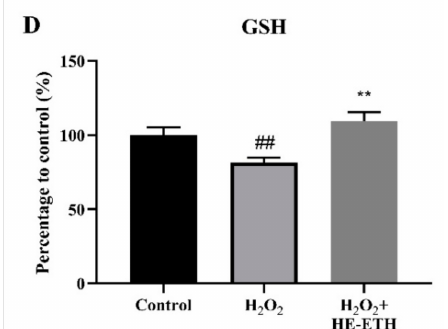
Figure 5. Antioxidant activities of ethanolic extract (HE-ETH) on H 2 O 2 -treated HT22 neurons. HT22 was co-incubated with 250 µ M H 2 O 2 and 400 µ g / mL HE-ETH before subjected to series of antioxidant assays. ( A ) Representative images of intracellular reactive oxygen species (ROS) stained by 2’,7’-dichlorodihydrofluorescin diacetate (DCFH-DA) with quantification of ( B ) ROS level, ( C ) catalase (CAT) activity and ( D ) glutathione (GSH) content. All values presented correspond to mean ± SD of triplicates ( n = 3). Values of # p < 0.05; ## p < 0.01 compared with control, and * p < 0.05; ** p < 0.01